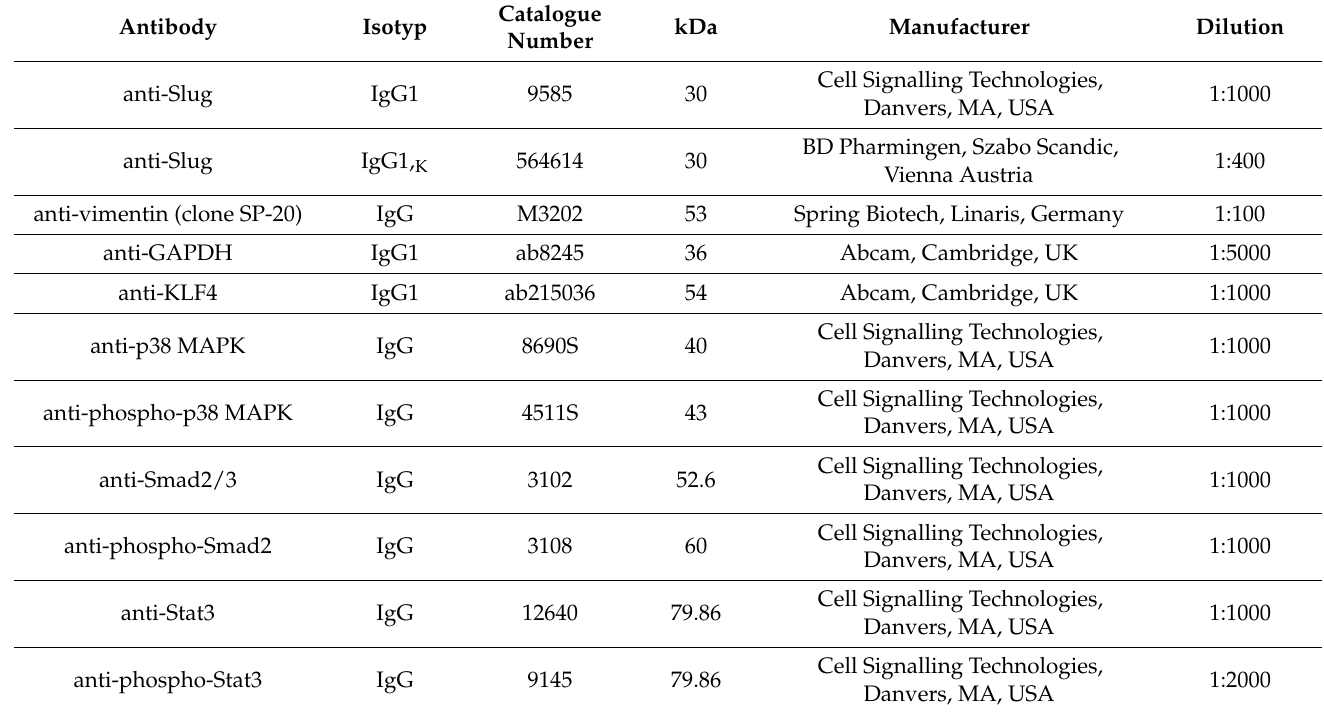
Table 3. Overview of primary utilized antibodies for western